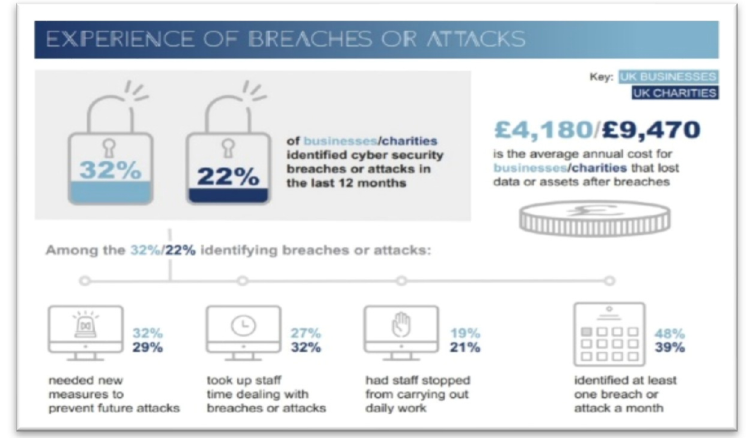
Figure 1. Cyberscurity Breach Survey 2019, Department of Digital, Culture, Media, and Sports UK [23].